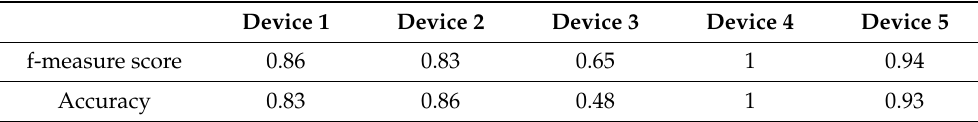
Table 1. Performance of SC-M algorithm applied on ideal data.